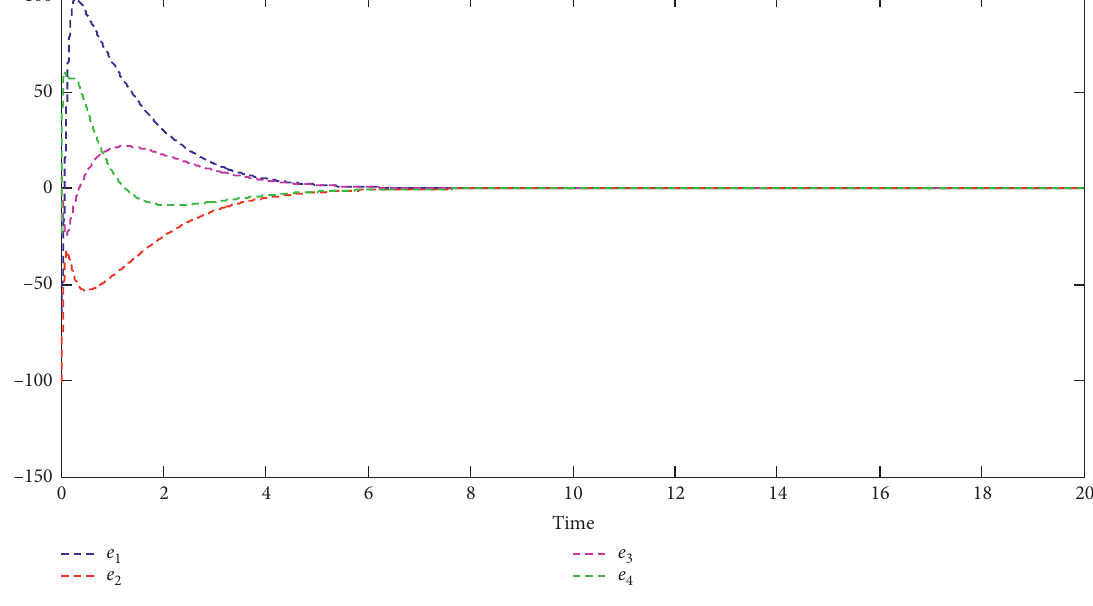
Figure 5: Synchronization